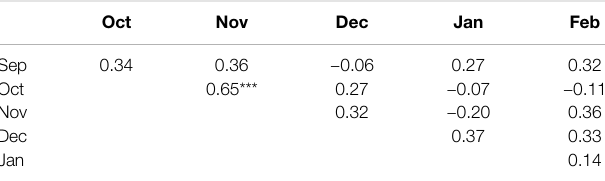
TABLE 3 | As in Table 1 , but for 1999 –